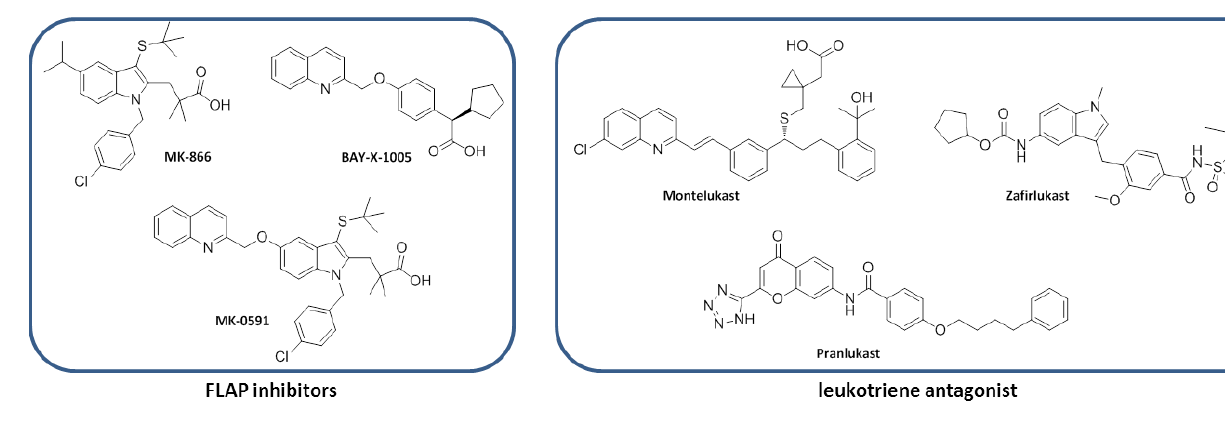
Figure 2. Lipoxygenase